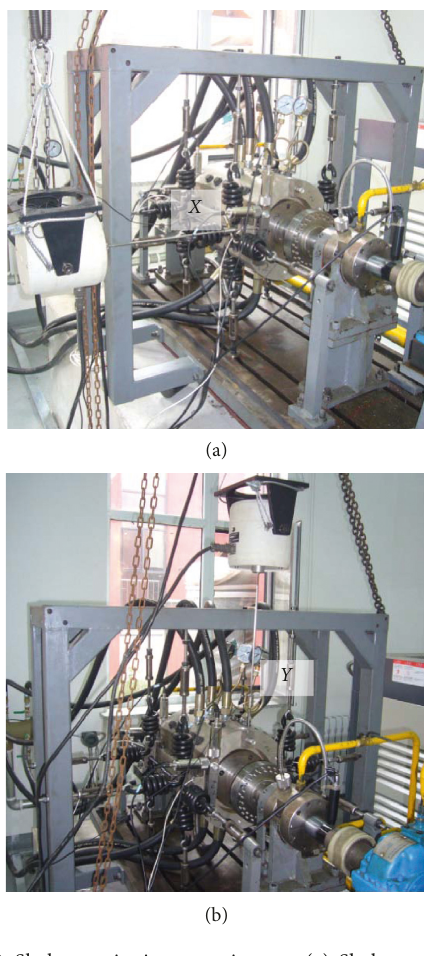
Figure 7: Shaker excitation experiments. (a) Shaker excited in x direction. (b) Shaker excited in y direction.